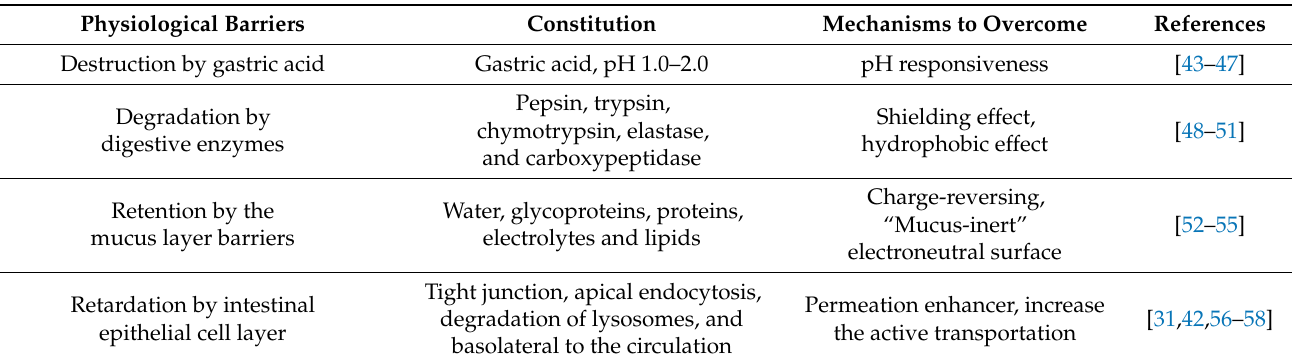
Table 1. The physiological barriers of oral insulin administration and the